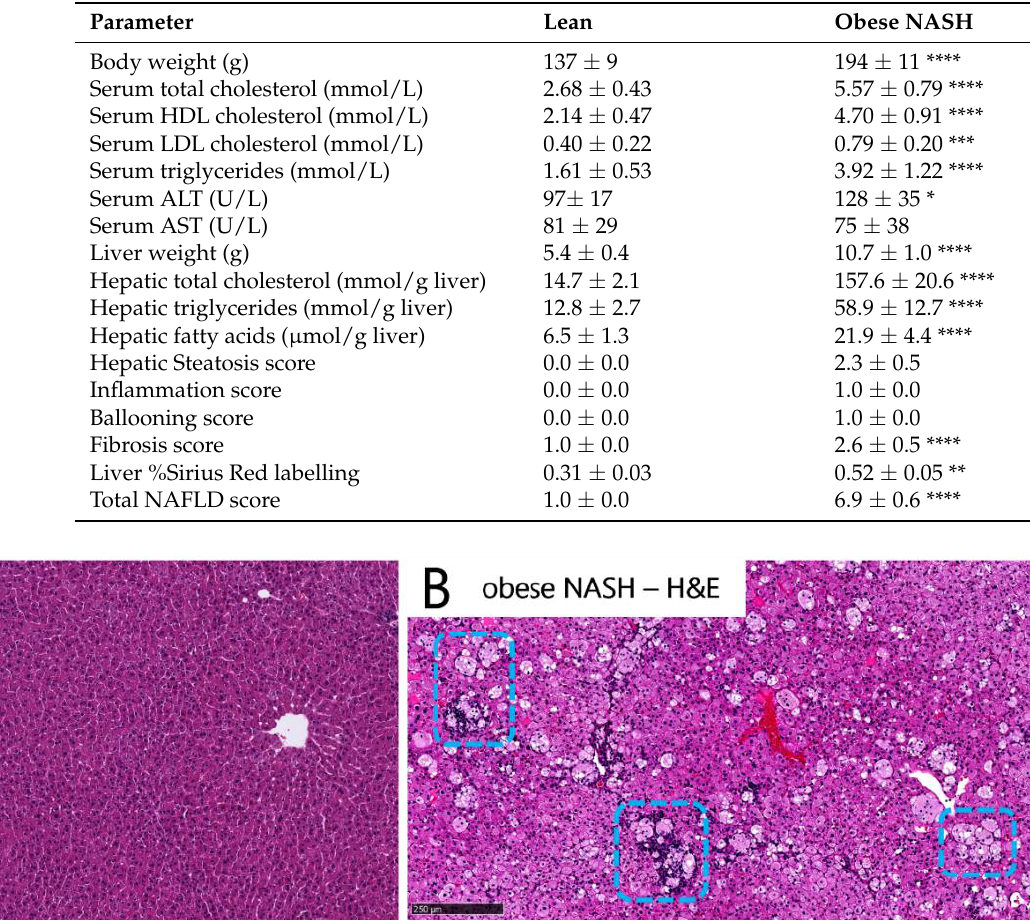
Figure 1. Free-choice-diet-induced obesity, NASH/liver fibrosis, and lung inflammation. ( A – D ) Representative liver histology images after H&E staining ( A , B ) and Sirius Red staining ( C , D ) of lean hamsters ( A , C ) and obese NASH hamsters ( B , D ), respectively. Blue dashed squares indicate inflam- matory foci and hepatocyte ballooning, and green arrows indicate liver fibrosis. ( E ) Cytokeratin-18 (CK18) immunostaining of liver samples from obese NASH hamsters. Black dashed squares indicate clusters of ballooned hepatocytes lacking cytokeratin-18. ( F ) Hepatocyte ballooning is shown at a higher magnification. ( G ) Serum levels of MCP-1 and IL-6 and ( H ) lung levels of IL-6 protein in lean hamsters and obese NASH hamsters. Data are shown as the mean ± SD ( n = 10 animals per group). Significant differences were determined using an unpaired, two- tailed Student’s t -test or a Mann – Whitney U test (* p < 0.05; ** p < 0.01; *** p < 0.001). Scale bars: 250 µm ( A – F ) .